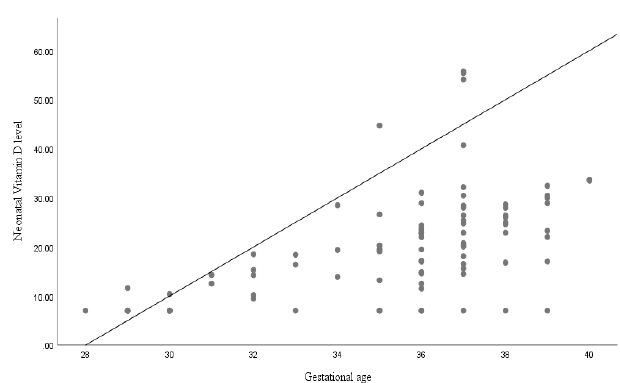
Figure 3 : Correlation between neonatal Vitamin D levels and gestational age (r = 0.106, p = 0.328 ((not significant)). The mean of Vitamin D level in full term neonates was (26.18 ± Table 3: Mean of neonatal Vitamin D levels and standard deviation. Baby vitamin D